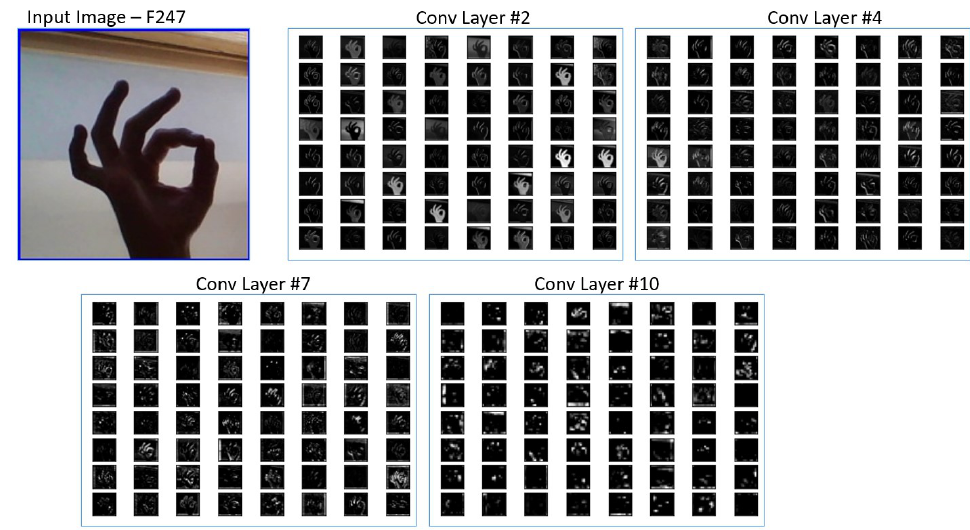
Figure 4. Feature map visualization.